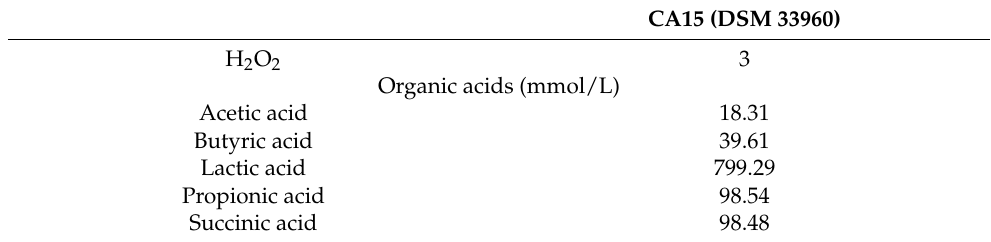
Table 3. Hydrogen peroxide (H 2 O 2 ) production and organic acid profile exhibited by the L. rhamno- sus CA15 (DSM 33960) strain.